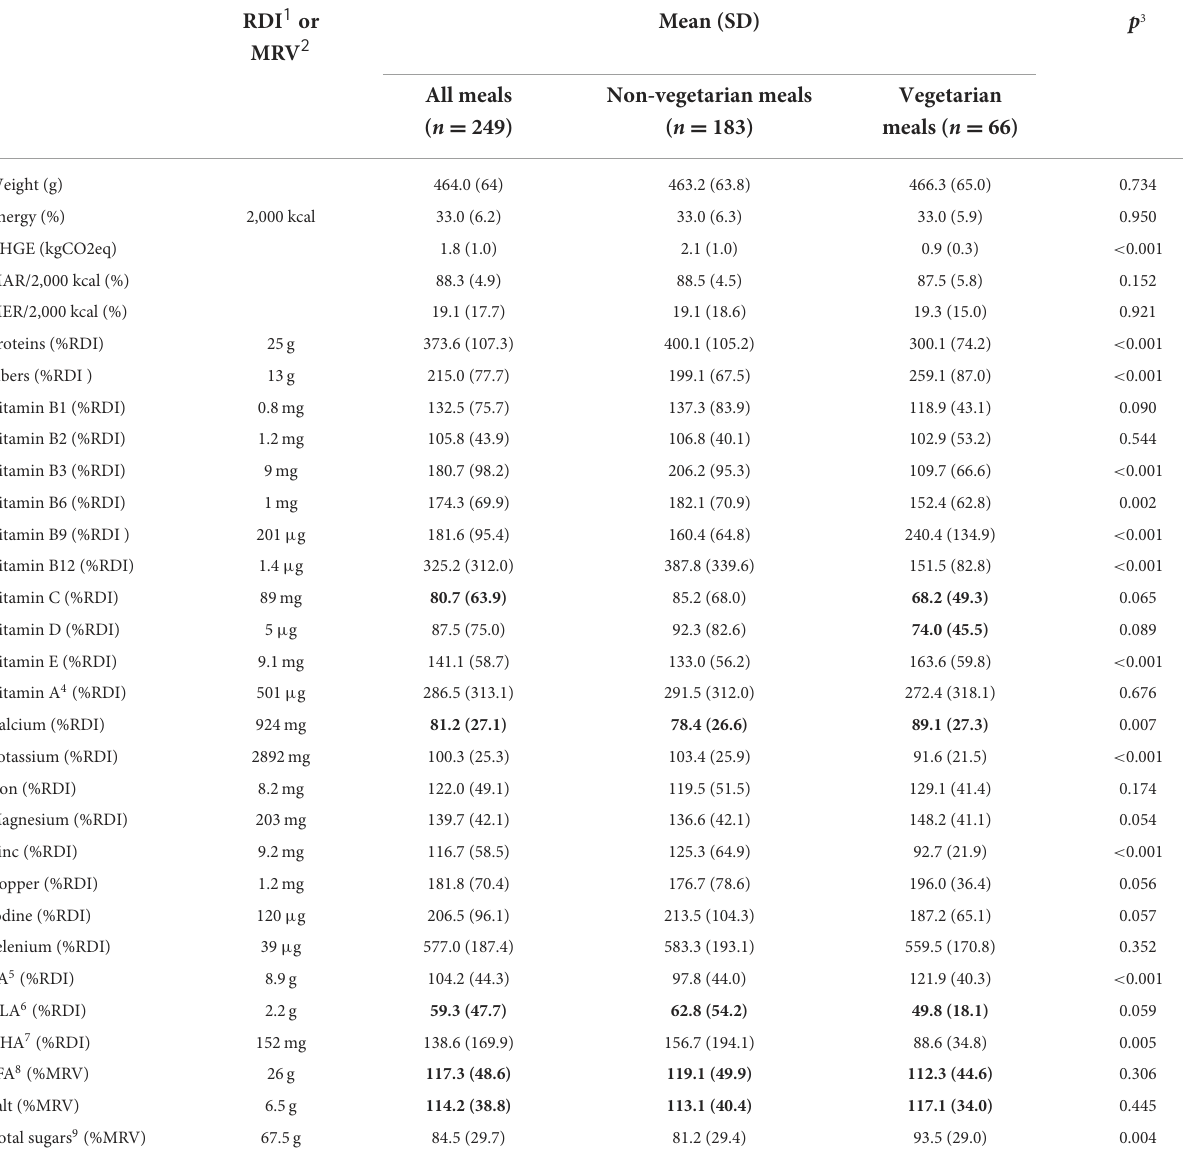
TABLE 2 Nutritional quality and environmental impact of all meals ( n = 249), non-vegetarian ( n = 183) and vegetarian meals ( n = 66) served in the Dijon school canteens in 2019. RDI 1 or Mean (SD) p 3 MRV 2 All meals